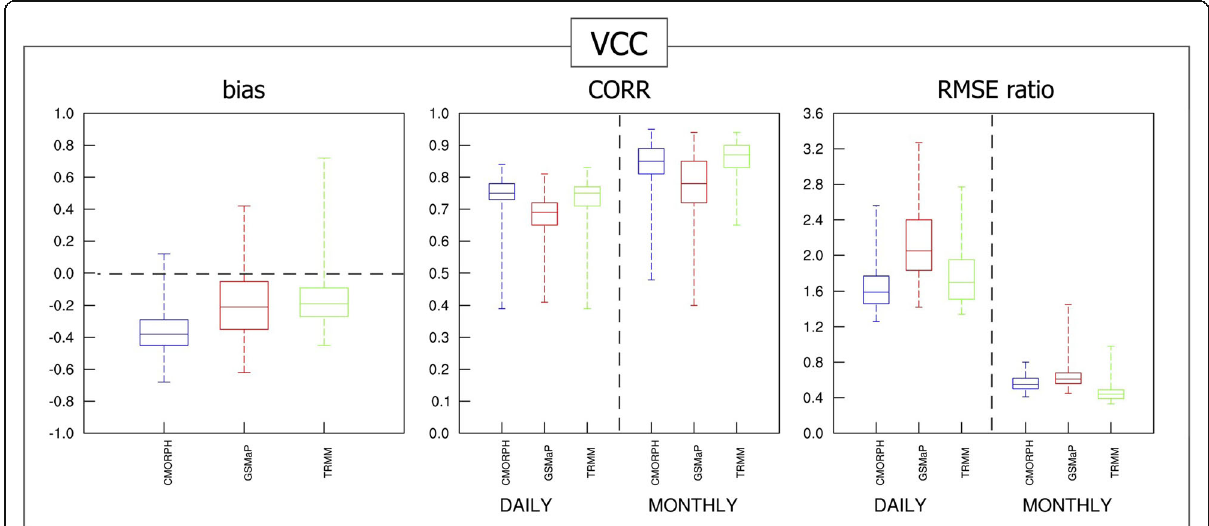
Fig. 9 Same as Fig. 6, except for SOND rainfall over the VCC for 85 grid point values. Sample numbers are N = 1220 for each bias value, N = 1,220 for each CORR or RMSE ratio value for daily rainfall, and N = 40 for each CORR or RMSE ratio value for monthly rainfall